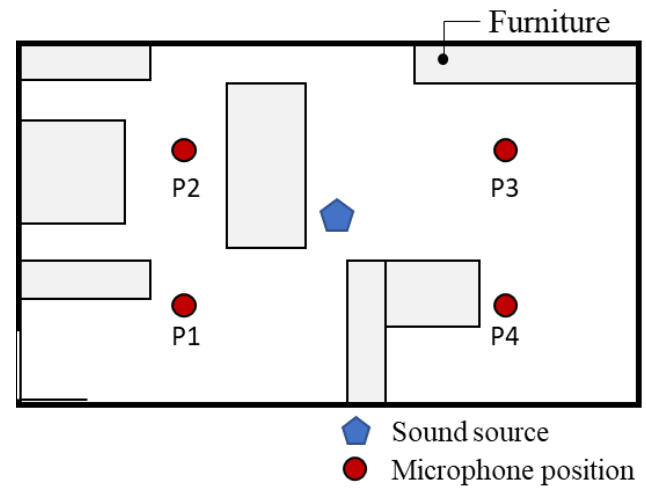
Figure 17. The position of the measurement points.